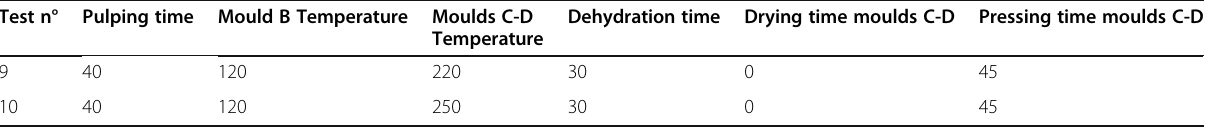
Table 7 Optimized process parameters from Taguchi